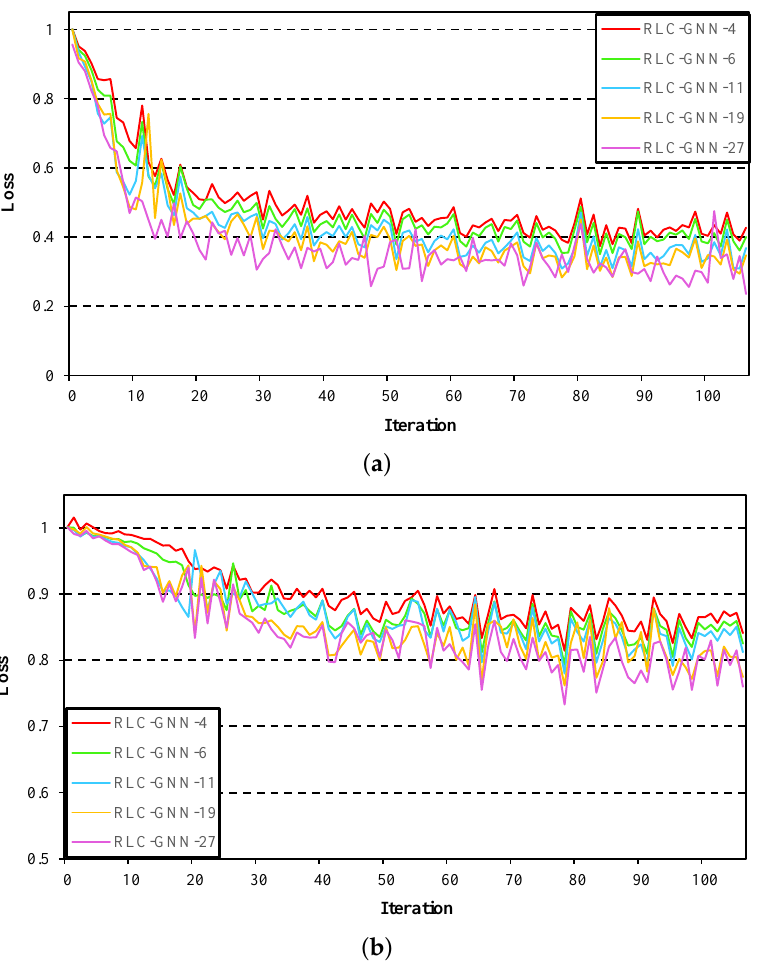
Figure 12. The normalized training loss for RLC-GNN with varying depth on Amazon dataset ( a ) and Yelp dataset ( b ). As it can be seen, an obvious characteristic on both dataset is that the overall training loss is lower with the increasing of